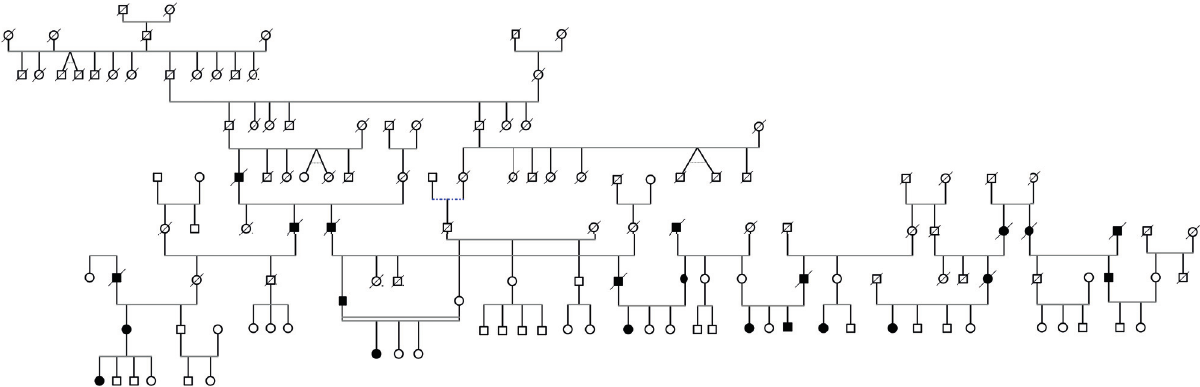
Fig. 2. Large family tree with apparent autosomal-dominant inheritance pattern of parkinsonism spanning generations from 1840 to the